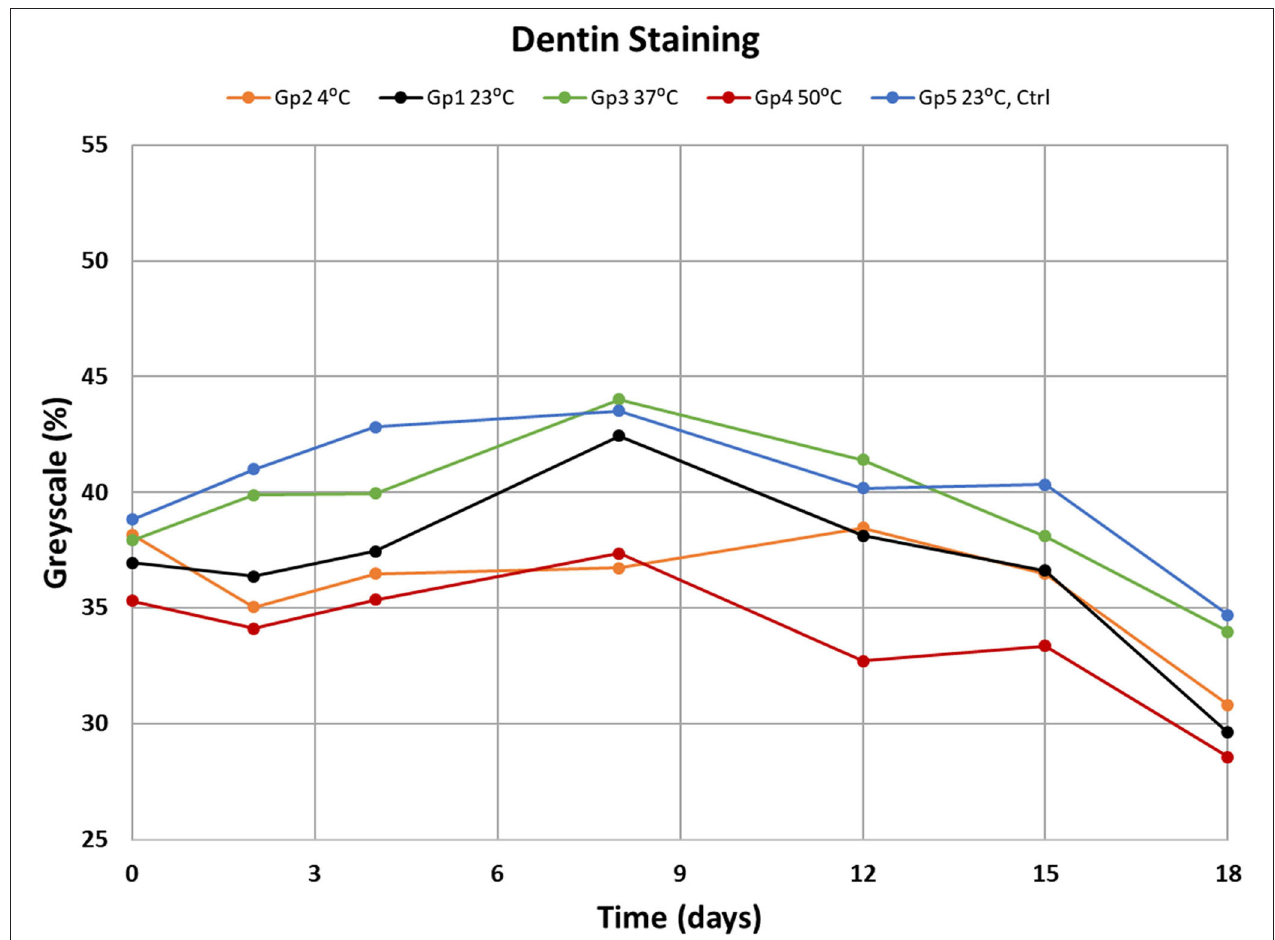
FIGURE 5 | The grayscale % graph of the temperature groups and control group over